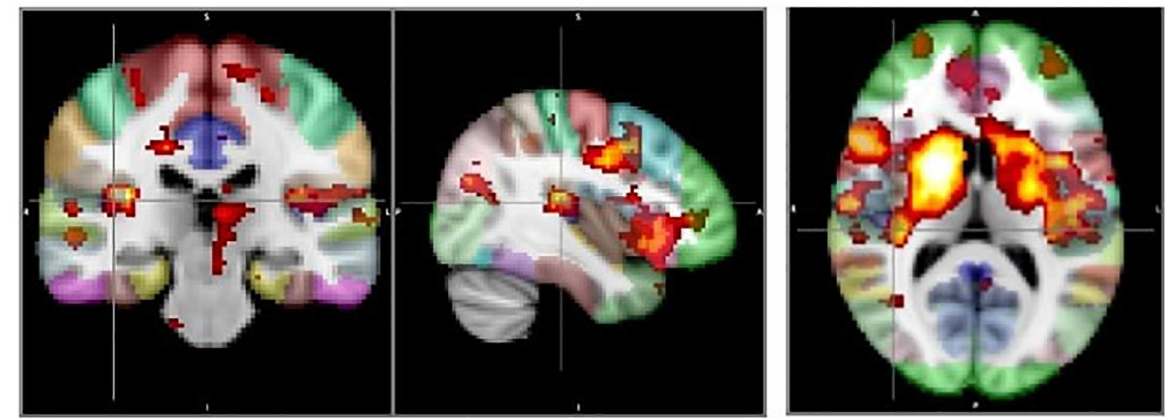
Fig 2. Voxel-based analysis for the right hemisphere insula-seeded correlation maps. Note: FDR-corrected significantclusters: Heschl’s gyrus, superiortemporal gyrus (p’s < 0.05); FDR trend-levelclusters: anterior cingulategyrus, caudate.